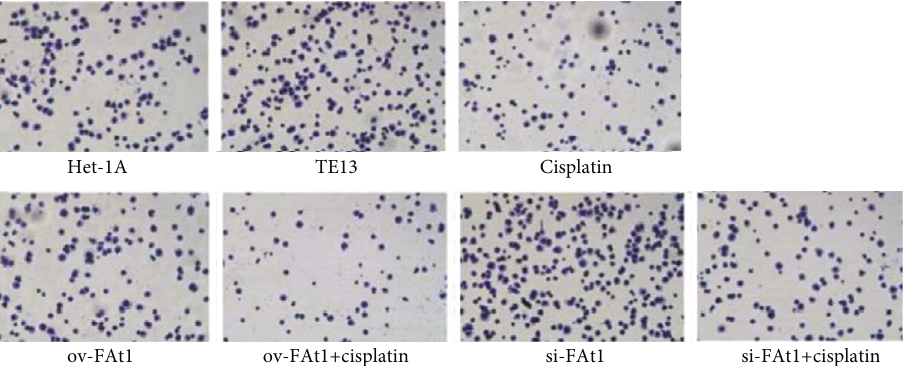
Figure 5: FAT1 inhibits the adhesion of human esophageal cancer cell lines. Fibronectin-coated dishes were used to detect the characteristics of cell adhesion to extracellular matrix in each experimental group (het-1A cell line, TE13 cell line, TE13 cells treated with cisplatin, and TE13 cells transfected with ov-FAT1 and si-FAT or treated with cisplatin at the same time). Magni fi cation: 200